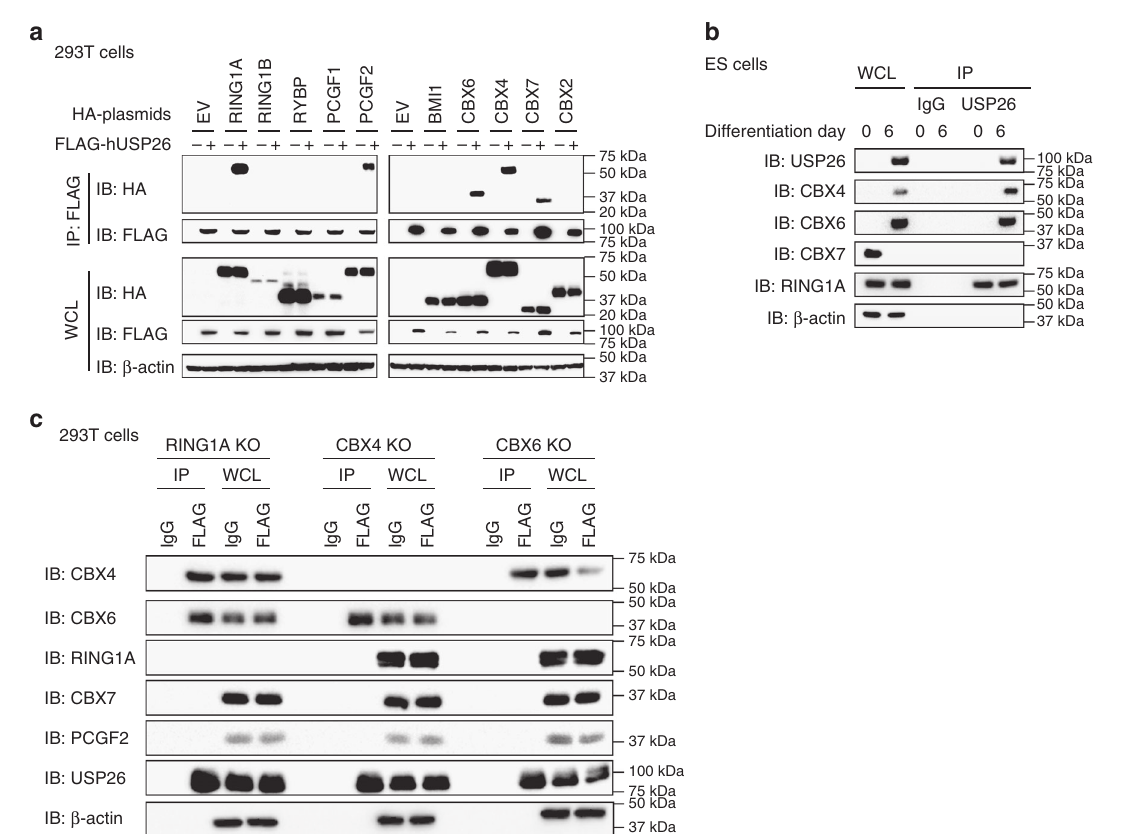
Fig. 4 USP26 interacts with PRC1 components. a 293T cells were transfected with HA-tagged RING1A, RING1B, RYBP, PCGF1, PCGF2, BMI1, CBX4, CBX6, CBX7, or CBX2 plus FLAG-hUSP26 or empty vector. Following IP with anti-FLAG beads, speci fi c proteins were analyzed by western blotting using anti-HA antibody. b Mouse ESCs were infected with or without mouse USP26 lentivirus, and cell extracts were harvested at different time points, immunoprecipitated with anti-USP26 antibody, and analyzed by western blotting using speci fi c antibodies, as indicated. c RING1A, CBX4, and CBX6 knockout (KO) 293T cells were transfected with FLAG-USP26, cell extracts were harvested, immunoprecipitated with anti-FLAG antibody, and analyzed by western blotting using speci fi c antibodies, as